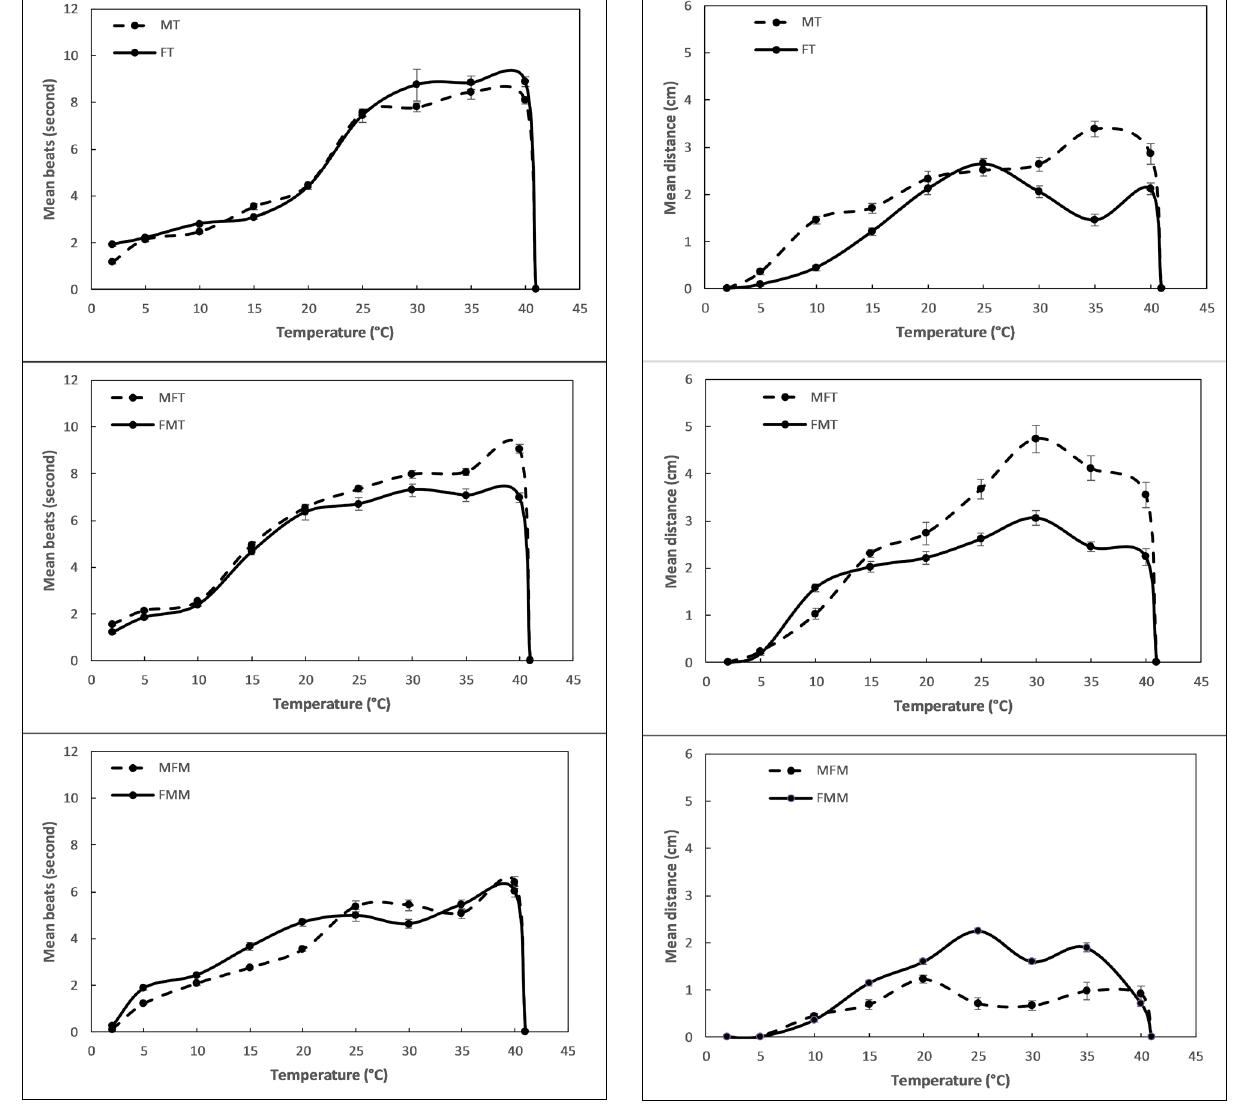
Figure 2. Comparison of swimming activities between male and female Branchipus schaefferi as a function of different temperatures and culture conditions (MT: males in tap water; FT: females in tap water; MFT males in the presence of females in tap water, FMT: females in the presence of males in tap water; MFM: males in female culture medium; FMM: females in male culture medium).